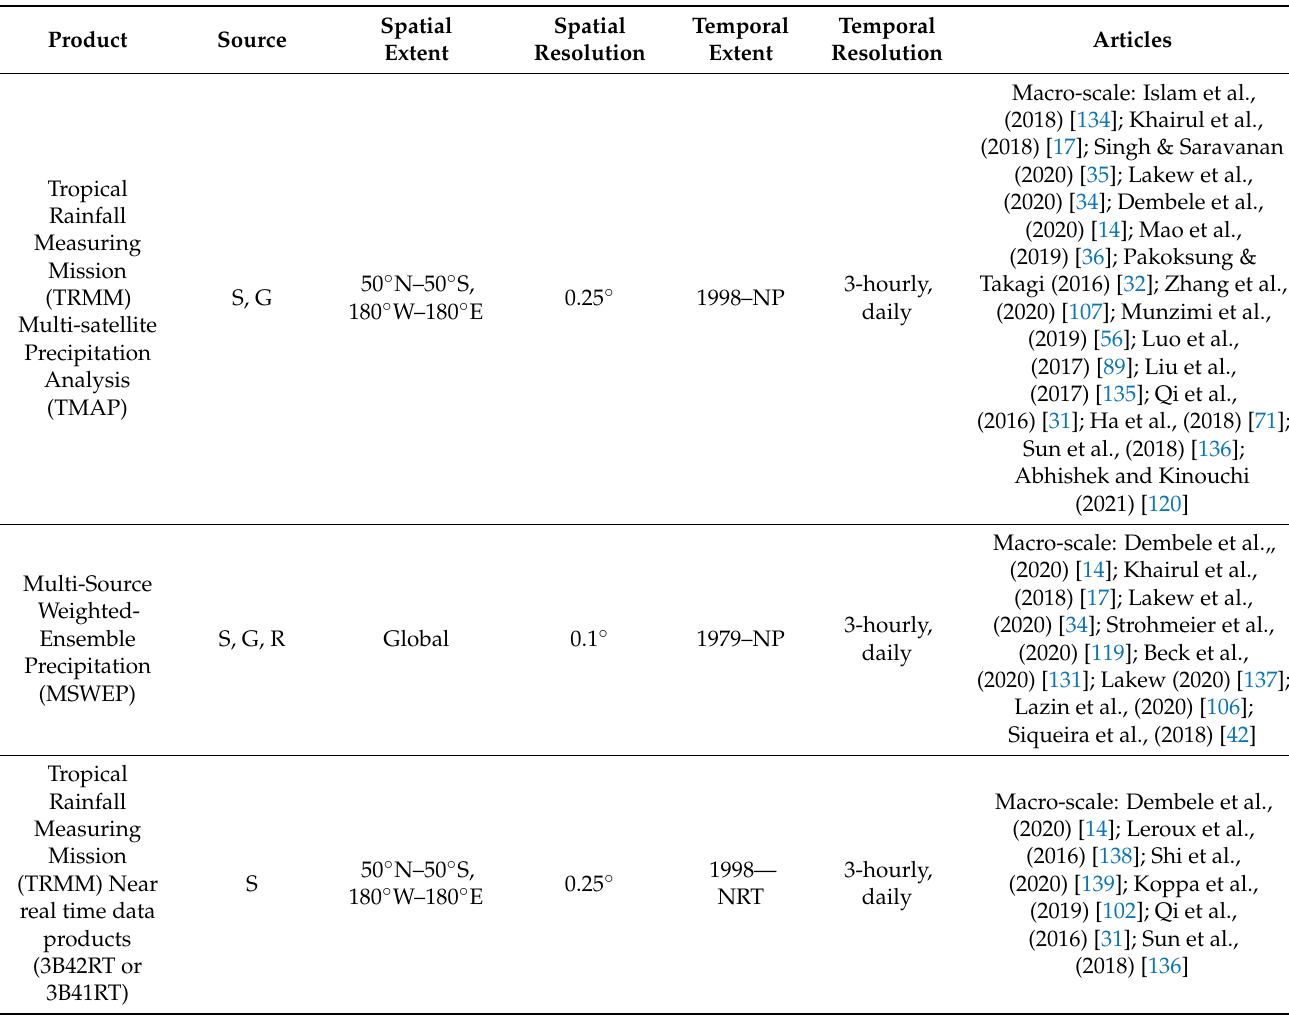
Table A1. Precipitation datasets used in reviewed